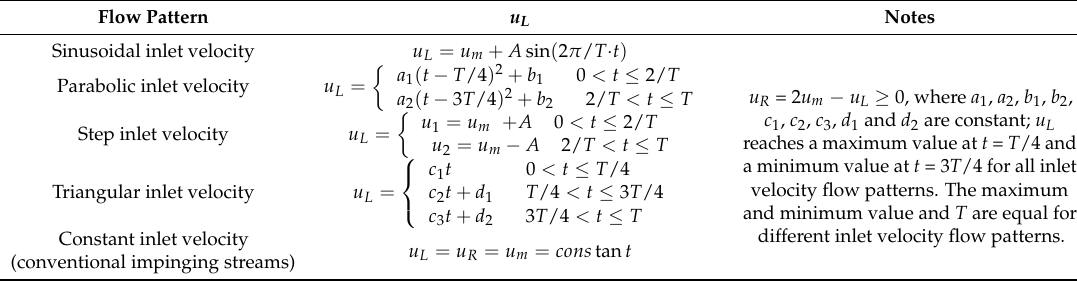
Table 1. Different inlet velocity flow